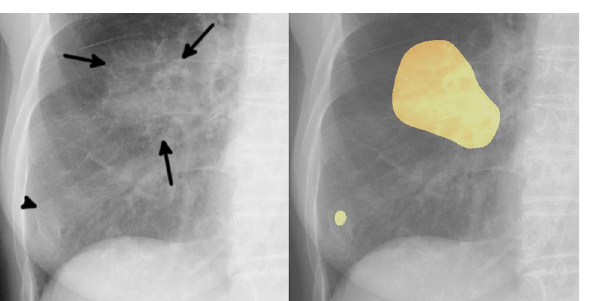
Figure 4. Example of one false positive case. The image on the left is an original image, and the image on the right is an image output by our model. An 81-year-old woman with a mass in the right lower lobe that was diagnosed as squamous cell carcinoma. The mass in the right middle lung field (arrows) was carcinoma. Our model detected this lesion, and also detected a slightly calcified nodule in the right lower lung field (arrowhead). This nodule was an old fracture of the right tenth rib, but was misidentified as a malignant lesion because its shape was obscured by overlap with the right eighth rib and